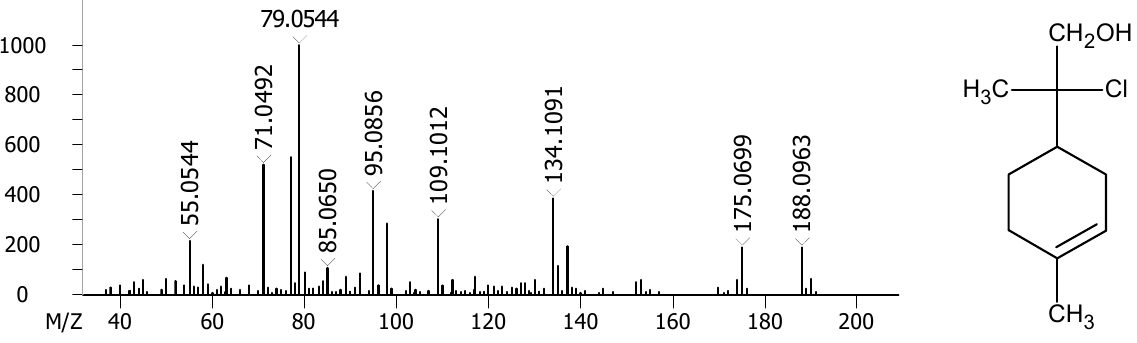
Figure 5. Mass spectrum and formula of 1-methyl-4-(2-chloro-1-hydroxyprop-2-yl)cyclohexene with RT 845s.